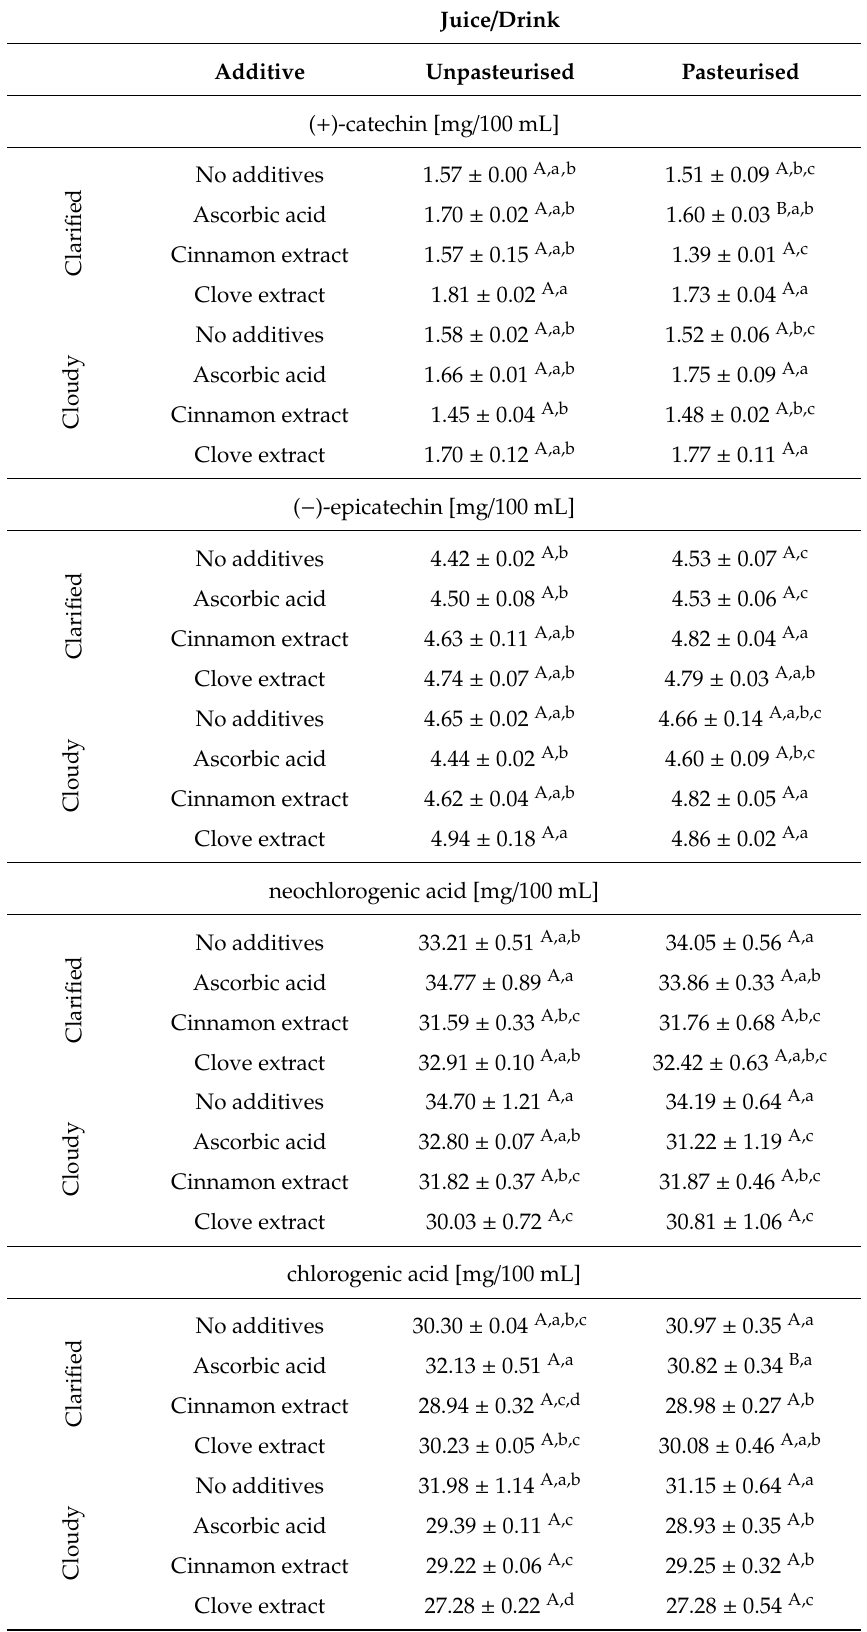
Table 1. Phenolic acids and flavanols content before and after juice / drink